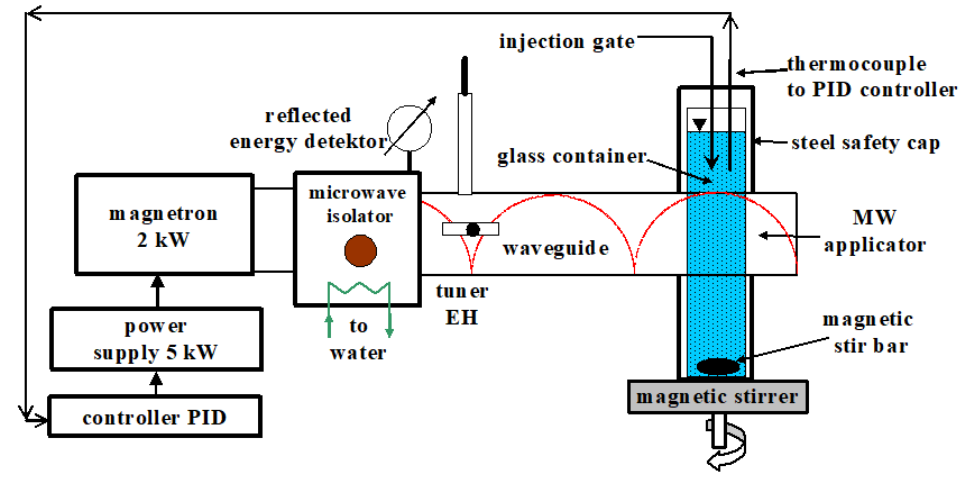
Figure 1. Single-mode laboratory setup for microwave-assisted synthesis of AgNWs.